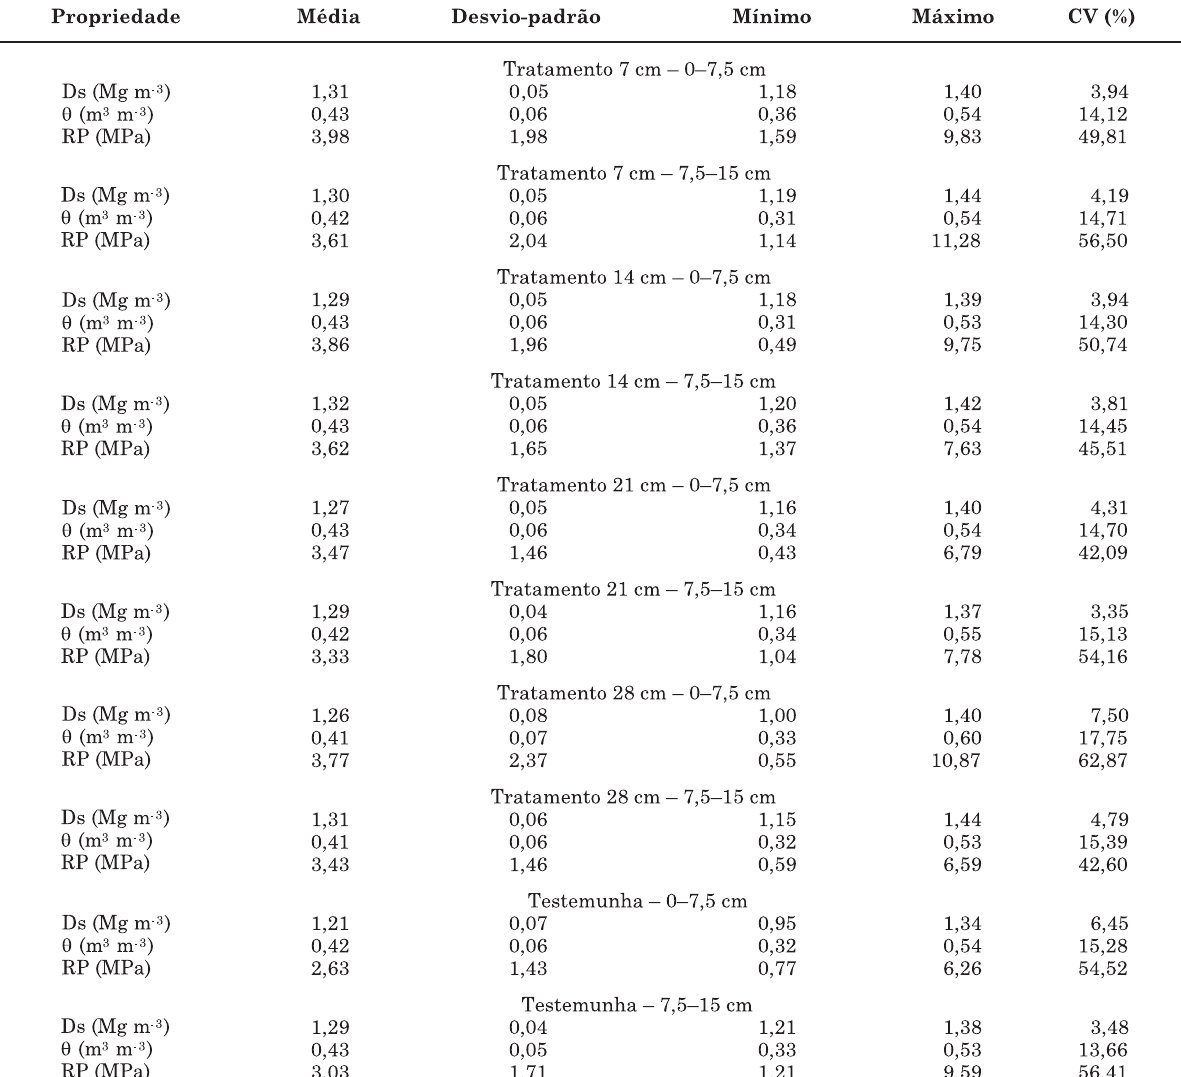
apresentada na figura 1. Em todos os tratamentos foi constatado que, com o aumento da Ds, ocorreu também aumento do teor de água para manter a resistência à penetração ( θ ), bem como decréscimo RP do teor de água para manter a porosidade de aeração ( θ ) (Figura 1), corroborando os resultados obtidos por PA Silva et al. (1994), Tormena et al. (2007), Imhoff et al. (2001), Araújo et al. (2004) e Leão et al. (2004). Constatou-se que a θ foi superior ao conteúdo de água RP ) para todos os no ponto de murcha permanente ( θ PMP tratamentos, indicando que a resistência à penetração é uma variável de grande importância no controle da qualidade física desse